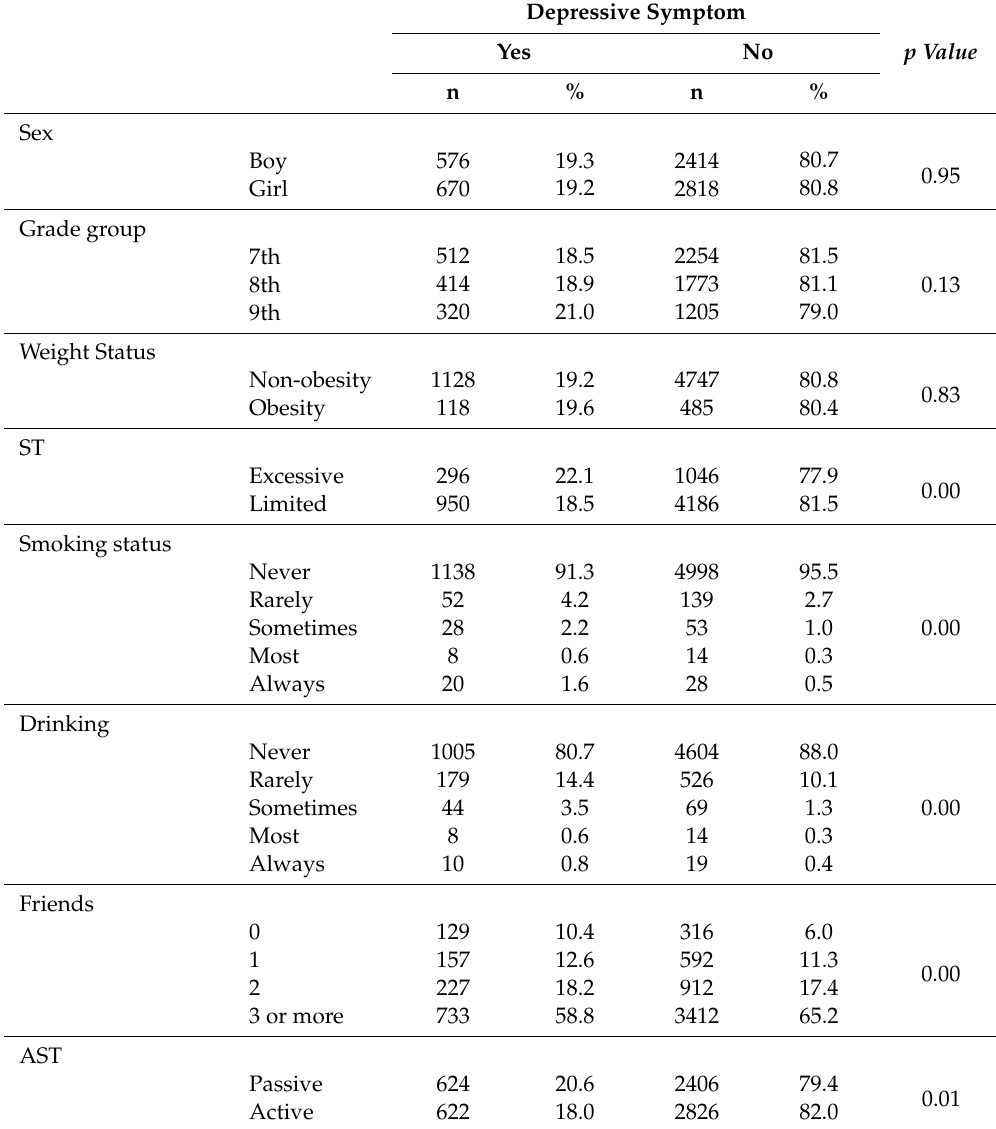
Table 2. Di ff erences in depressive symptom by